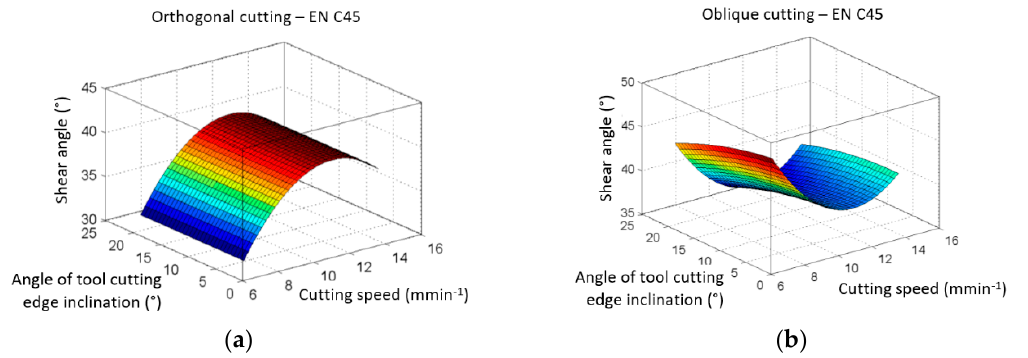
Figure 14. The dependence of shear angle Φ on cutting speed v c and on the angle of tool cutting edge inclination λ s ; ( a ) orthogonal cutting; ( b ) oblique cutting.